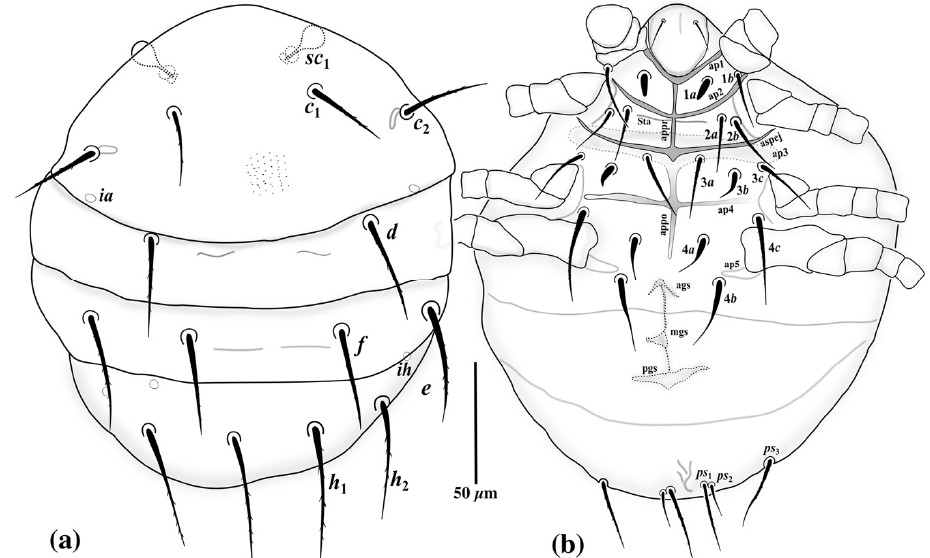
Insects 2022 , 13 , x FOR PEER REVIEW Figure 6. Archidispus hydrophilus sp. nov. ( a ) dorsal view of body; ( b ) ventral view of body. Figure 6. Archidispus hydrophilus sp. nov . ( a ) dorsal view of body; ( b ) ventral view of body. Legs (Figure 7). Leg I (Figure 7a): distinctly thicker and shorter than other legs; setae formulae: Tr 1-Fe 3-Ge 4-TiTa 16(4) (number of solenidia in parentheses); tibiotarsus with a robust claw; all setae on tarsi smooth except setae l ″ and pv ″ ; tc ″ and ft ″ located apically and laterally, respectively, on a distinct pinnaculum; solenidia ω 1 13 (12–15) and ω 2 16 (15–18) baculiform, φ 1 11 (10–11) finger-shaped, φ 2 13 (11–14) very slender and baculi- form; all setae on genu, femur and trochanter smooth; setae d on femur short and spined, medially serrate. Leg II (Figure 7b): setae formulae: Tr 1-Fe 3-Ge 3-Ti 4(1)-Ta 6(1); empo- dium developed; seta u ′ smooth and indistinctly blunt-ended, tc ″ smooth and pointed, setae tc ′ , pv ″ and pl ″ on tarsus slightly barbed; ω 14 (13–15) elongate and baculiform; setae v ′ and v ″ on tibia weakly barbed; φ 9 (7–9) weakly clavate; seta l ″ on genu barbed; setae d on femur weakly blunt-ended; seta v ′ on trochanter moderately barbed and indistinctly blunt-ended. Leg III (Figure 7c): setae formulae: Tr 1-Fe 2-Ge 2-Ti 4(1)-Ta 6; empodium developed; u ′ shortest, smooth and indistinctly blunt; tc ″ smooth and pointed; pv ″ smooth and indistinctly blunt-ended; other tarsal setae moderately barbed; on tibia setae v ′ and v ″ barbed and indistinctly blunt-ended, d and l ′ smooth; solenidion φ 6 (7) uniform; on genu v ′ and l ′ smooth; on femur seta d barbed and pointed, l ′ smooth and slightly blunt-ended; on trochanter seta v ′ barbed and pointed. Leg IV (Figure 7d): the longest leg; setae formu- lae: Tr 1-Fe 2-Ge 1-Ti 3(1)-Ta 6; proximal portion of tarsus elongated, tapering to apex; all setae blunt-ended, u ′ smooth tc ″ smooth, seta pl ″ smooth and rod-like; other tarsal setae barbed; on tibia all setae barbed and indistinctly blunt-ended, solenidion φ 6 (6–7) thin and uniform; on genu seta v ′ barbed and pointed; on femur setae d and v ′ barbed and weakly blunt-ended; on trochanter seta v ′ sparsely barbed and pointed.